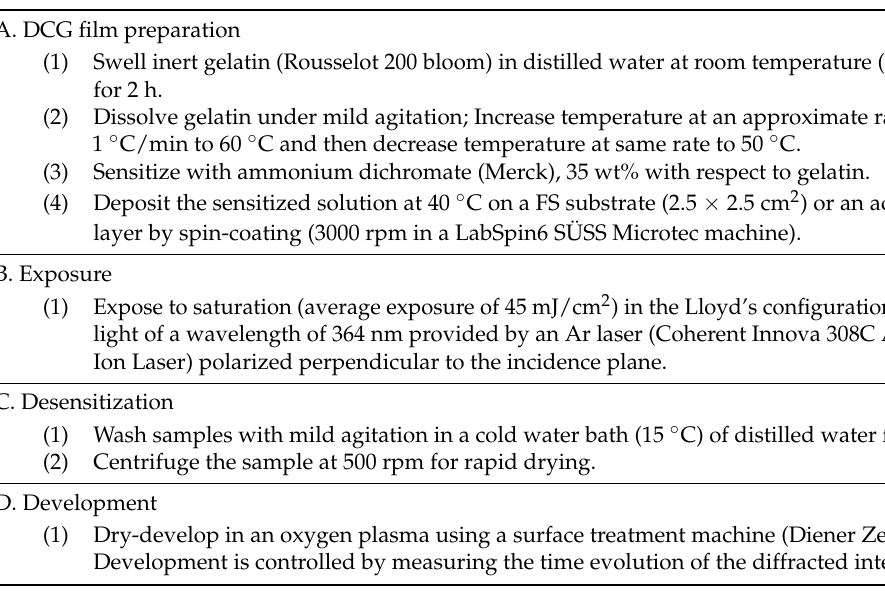
Table 1. Procedures to fabricate relief gratings on DCG